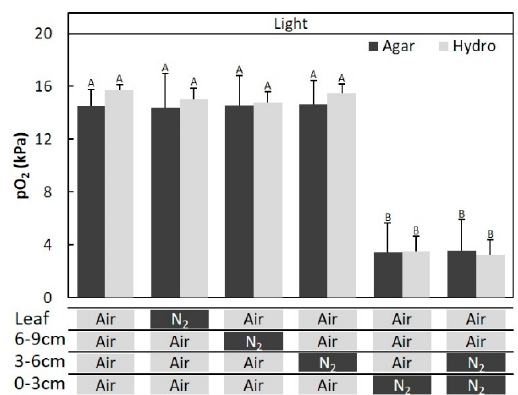
Figure 7. Entry portion of atmospheric oxygen in the stem of Syzygium kunstleri grown on hydroponic or agar media. Air or N 2 was injected into each part of the stem (0–3 cm, 3–6 cm, and 6–9 cm above the water level) and the leaf. N 2 was injected for 30 min through the cuvette covering the stem and for